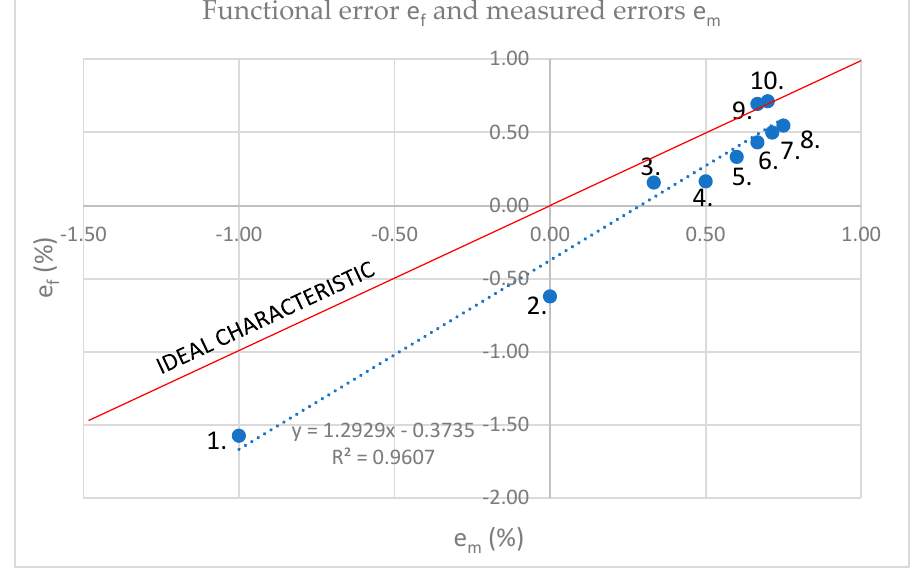
Figure 1. Ideal characteristic, measured point and regression line of CT at f = 100 Hz , T = 26.3 °C . Table 1. Example of functional and measured error for f = 100 Hz.